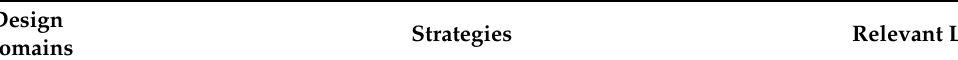
Table 3. Visual health design guidelines for school architecture.